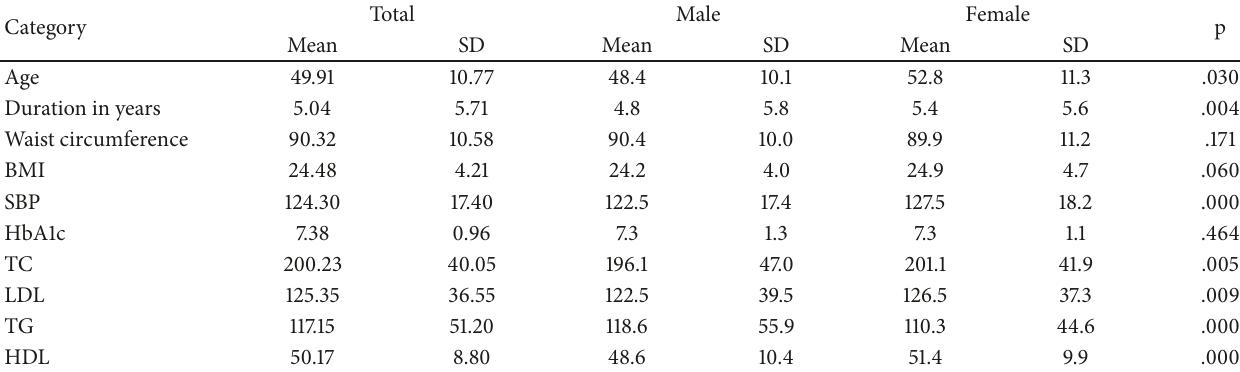
Table 1: Baseline characteristics of study